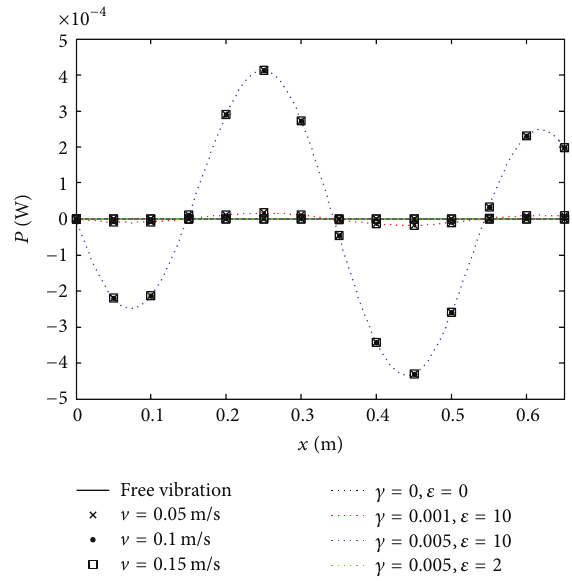
Figure 5: Power flow of the FMMB with disturbance